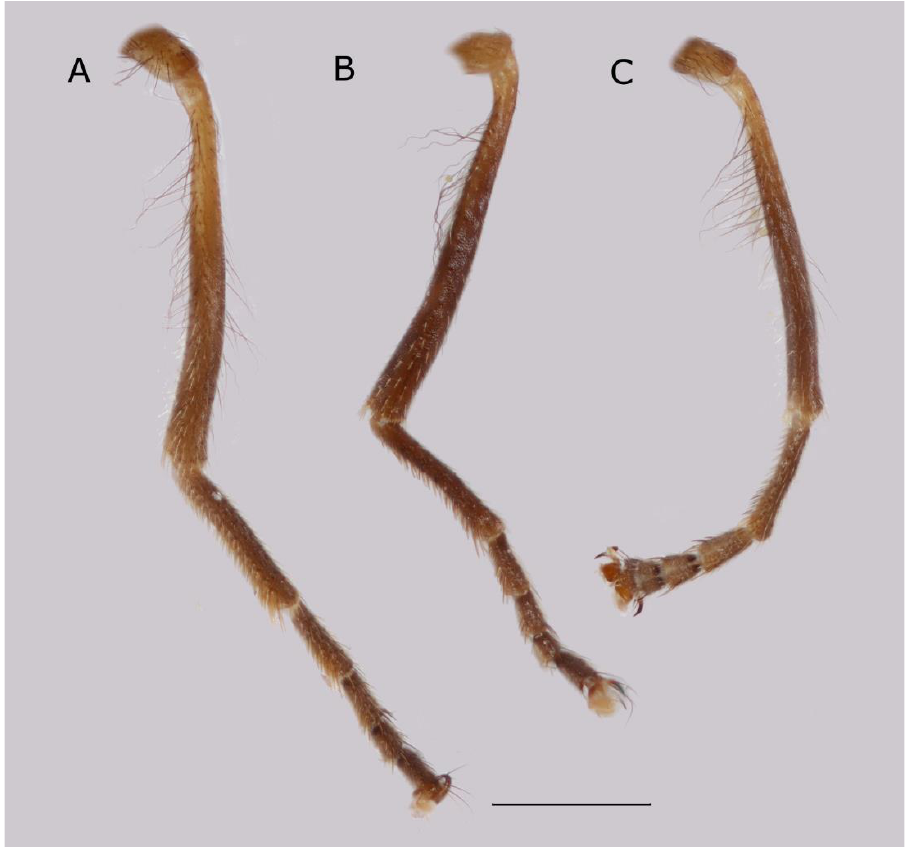
Figure 10. Adult male mesoleg, anterior view: (A) Platycheirus groenlandicus , Ammarnäs, Sweden; (B) Platycheirus subordinatus , Seitajaure, Sweden; (C) Platycheirus torei , Seitajaure, Sweden. Scale bar 0.5